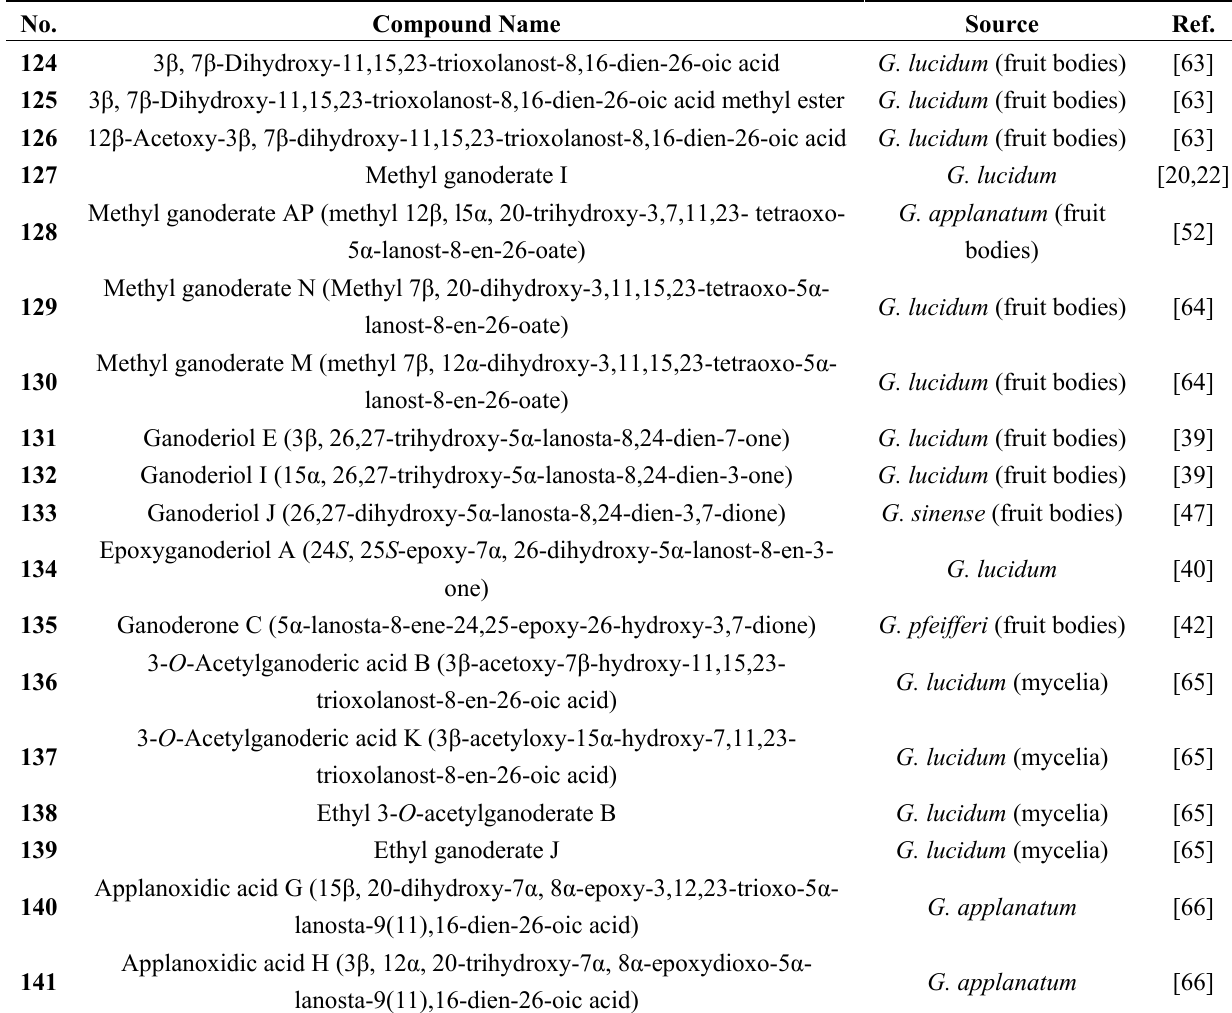
Table 5. Ganoderma triterpenes 124 – 147 in Figures 10–17 and Ganoderma triterpenes 148 – 155 in Figure